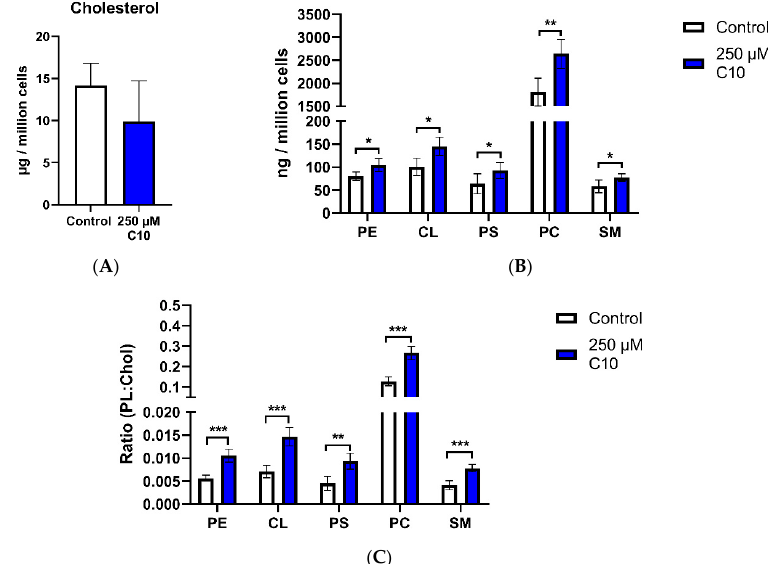
Figure 3. Cellular lipid quantities in HT22 neurons (control and C10 treated). Graph ( A ) presents cholesterol quantity (in µg per one million cells) measured using HPLC; graph ( B ) presents cellular phospholipid quantities (in ng per one million cells), measured using HPTLC; graph ( C ) presents ratios of individual phospholipids to cholesterol in the control and beta-hydroxybutyrate-treated groups. Data are presented as mean + SD ( n = 4–6); * p < 0.05, ** p < 0.01, *** p < 0.001. Chol—cholesterol; CL—cardiolipin; PC—phosphatidylcholine; PE—phosphatidylethanolamine; PL—phospholipid;